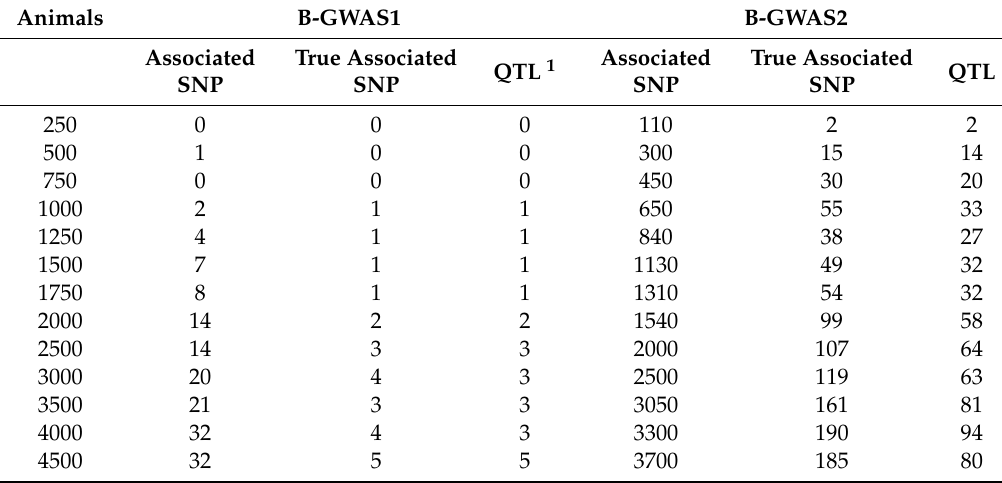
Table 2. Number of detected QTLs, false and true associated markers in the simulated dataset as the number of involved animals increases for both Bayesian (B-GWAS1 and B-GWAS2) GWAS methods.